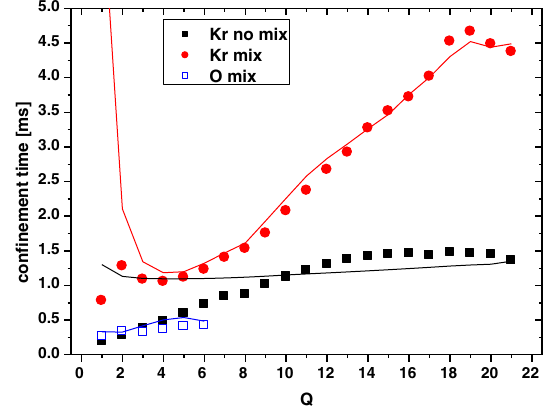
FIG. 11. Confinement times of krypton ions for the krypton plasma (black squares) and in the mix with oxygen (red circles) as a function of the ion charge state. Confinement times of oxygen ions in the mix are shown as the open blue squares. The Rognlien-Cutler fits are shown as the lines.